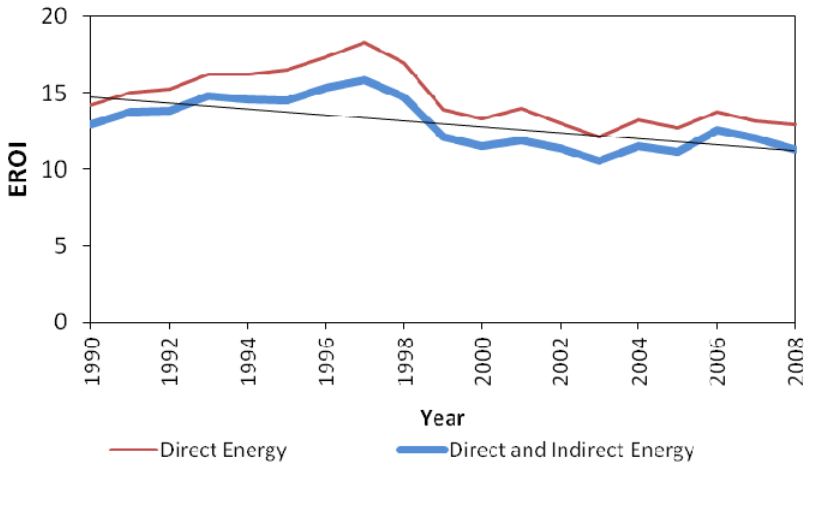
Figure 3. EROI for all Canadian Oil and Gas. The trend line is for Direct plus Indirect energy.